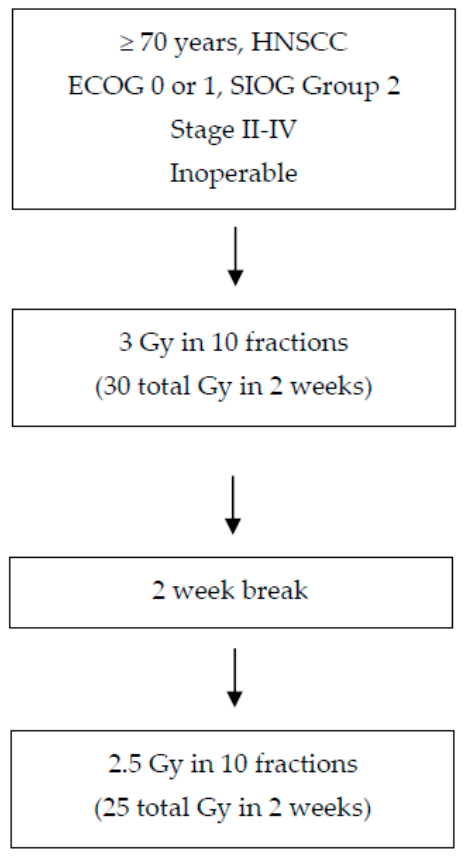
Figure 1. Schema of split course hypofractionation for older adult patients with head and neck squamous cell carcinoma unfit for standard treatment. For older adults with head and neck cancer that are suitable for standard treatment, consider standard treatment or enrollment onto a de-escalation trial if p16 positive.